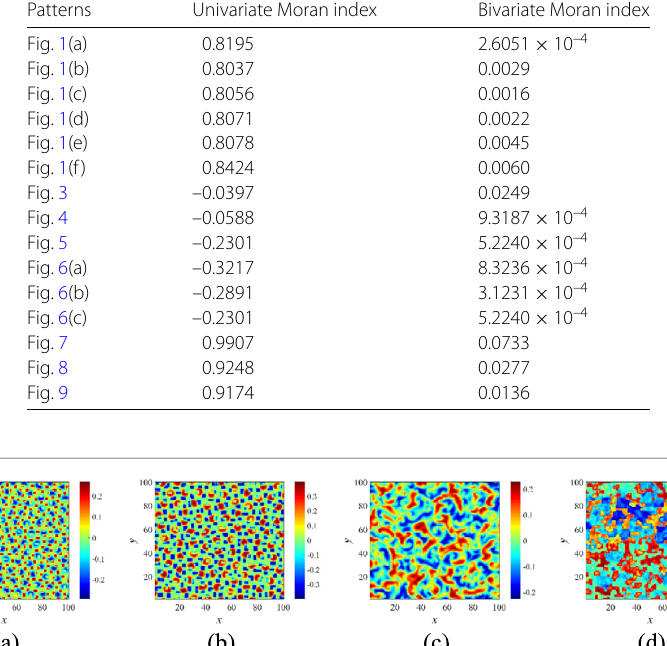
Table 1 Univariate and bivariate Moran index for the simulated patterns Patterns